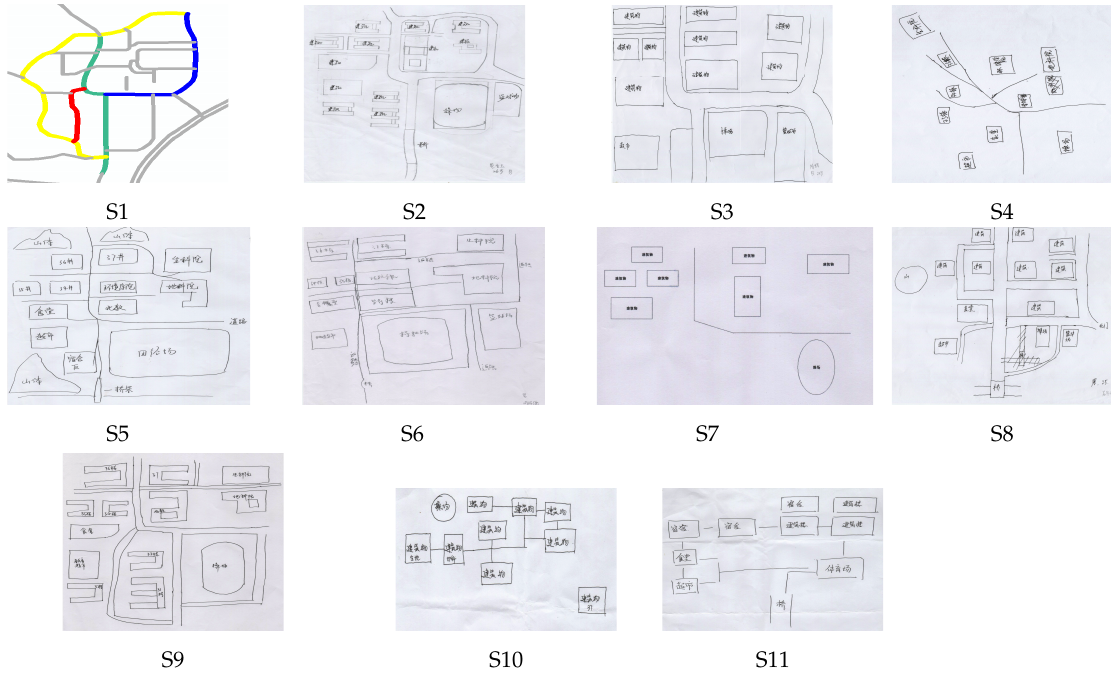
Figure 17. Sketches drawn by participants. Note that, the Chinese annotations in the sketches are the categories or names of the objects labeled by volunteers. S10 and S11 were not included in the subsequent analysis because the sketched roads in these two sketches were schematic and did not reflect the road